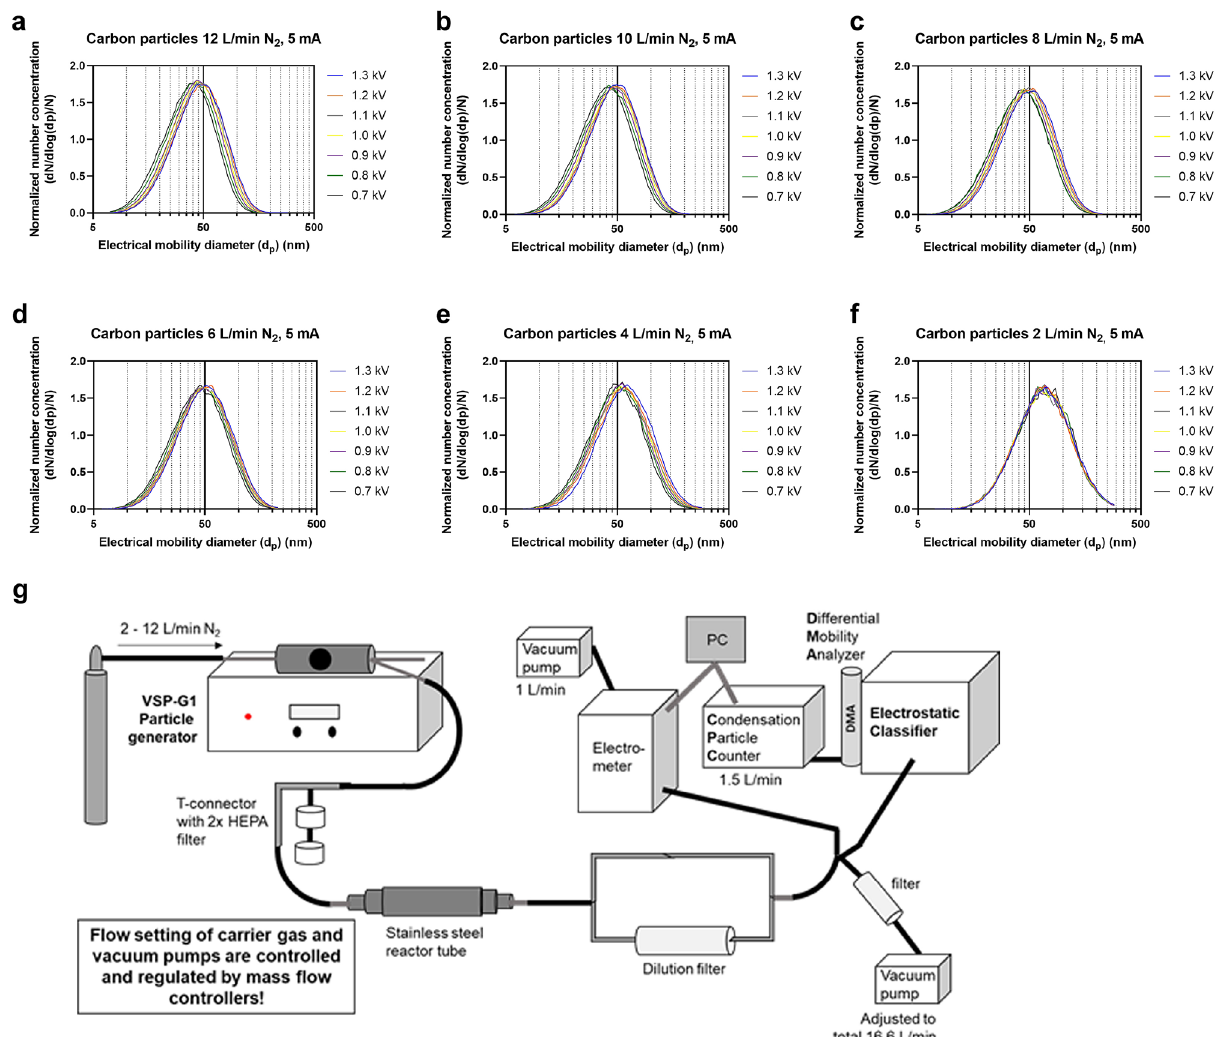
Figure 1. Physical, morphological and chemical characterization of CNPs generated by spark ablation. ( a–f ) Normalized particle number size distributions for different aerosol generator settings; carrier gas flow (2–12 L/ min), gap voltage 0.7–1.3 kV. ( g ) Schematic of the setup used for the initial physical characterization of spark- ablated carbon nanoparticles. VSP-G1 nanoparticle generator was supplied with nitrogen carrier gas at 2–12 L/ min flow. Generated particles were diluted with room air at the T-connector with two HEPA filters and guided through a tube system to be subsequently measured with a Scanning Mobility Particle Sizer consisting of an electrostatic classifier with a Differential Mobility Analyzer (DMA) and a Condensation Particle Counter (CPC), and an Electrometer. Appropriate flow parameters in the tubes and devices were set by vacuum pumps and regulated with mass flow controllers. Graphic was generated with the graphic tool from Microsoft Power